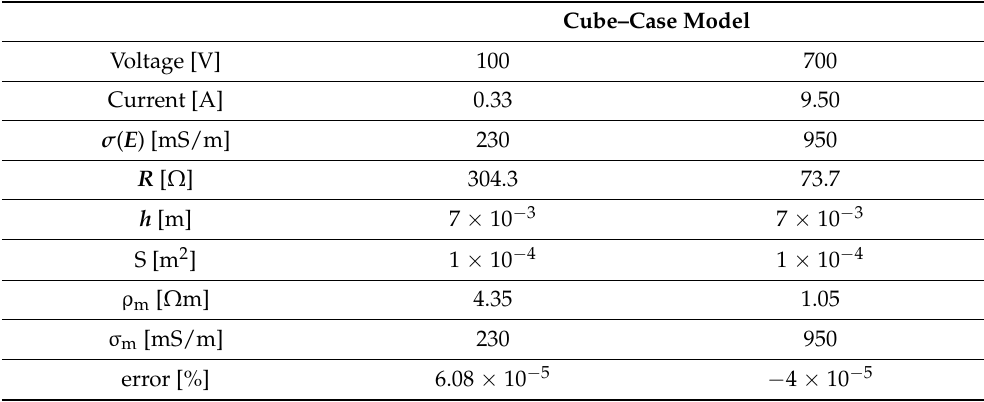
Table 5. Conductivity estimation using the FEM and assessment of the error of estimation for the cube-shape